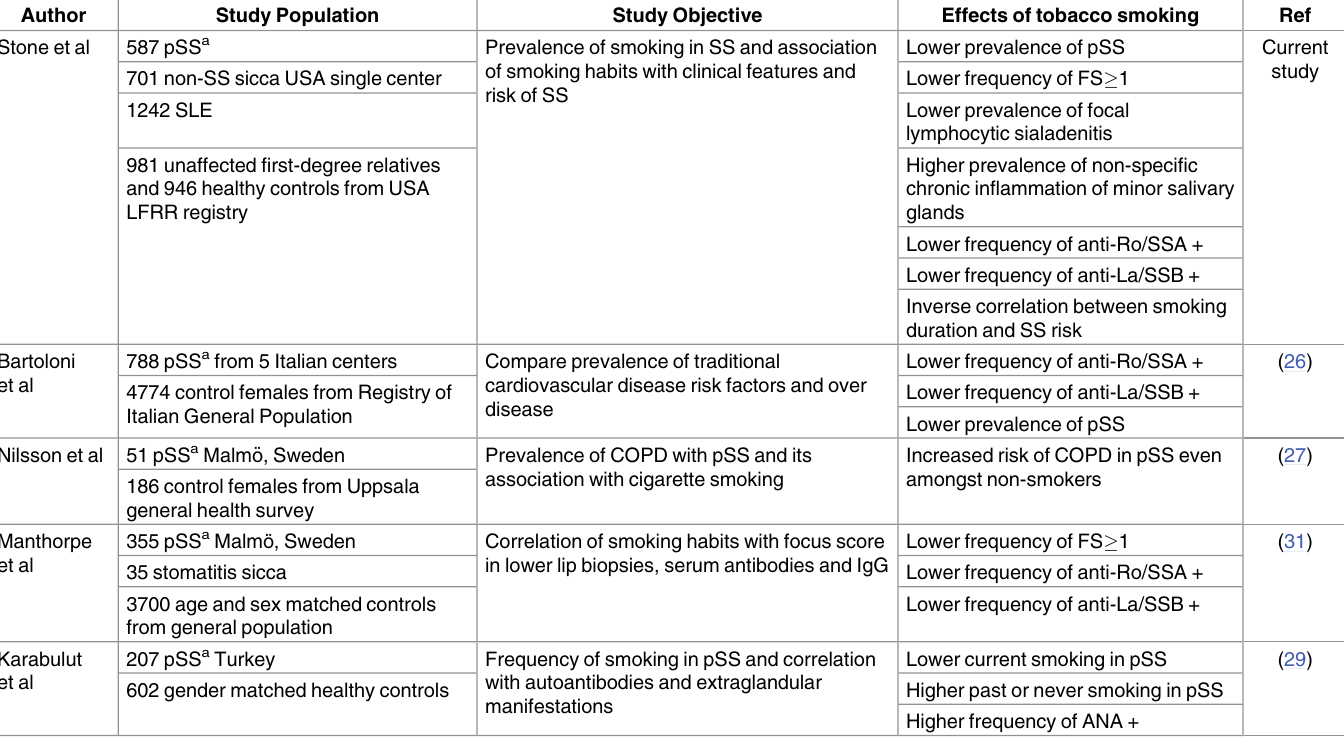
Table 6. Studies on the association between smoking and Sjo¨gren’s